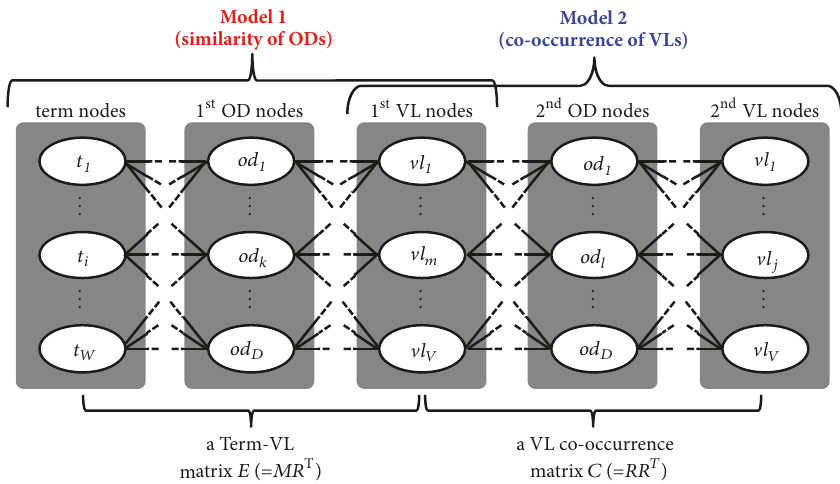
Figure 2: The structure of the Term-VL matrix 𝐸𝐶 [15] (partially modified by authors).